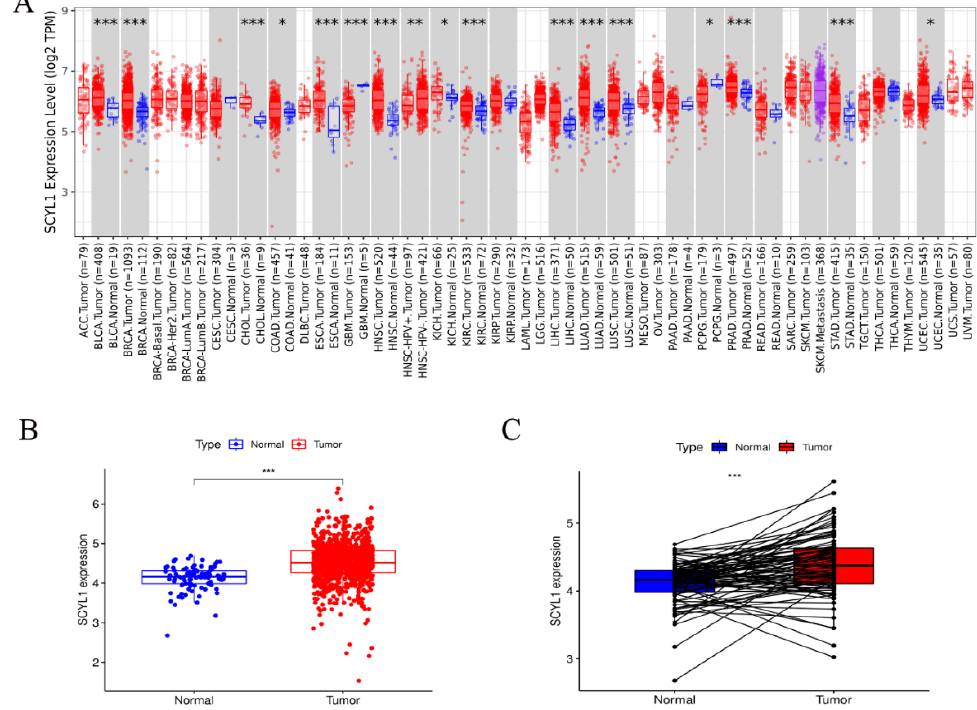
Figure 1. Analysis of SCYL1 expression in breast cancer in the breast cancer database. ( A ) The expression level of SCYL1 in different types of tumor tissues and normal tissues was assessed in TIMER2.0 database. ( B ) Based on the information of 95 normal and 942 tumor samples from Breast Cancer patients in The Cancer Genome Atlas (TCGA) database, the differential expression of SCYL1 was analyzed. ( C ) The pairing difference analysis of SCYL1 expression between the tumor and normal tissues from TCGA database. *: p -value < 0.05; **: p -value < 0.01; ***: p -value <